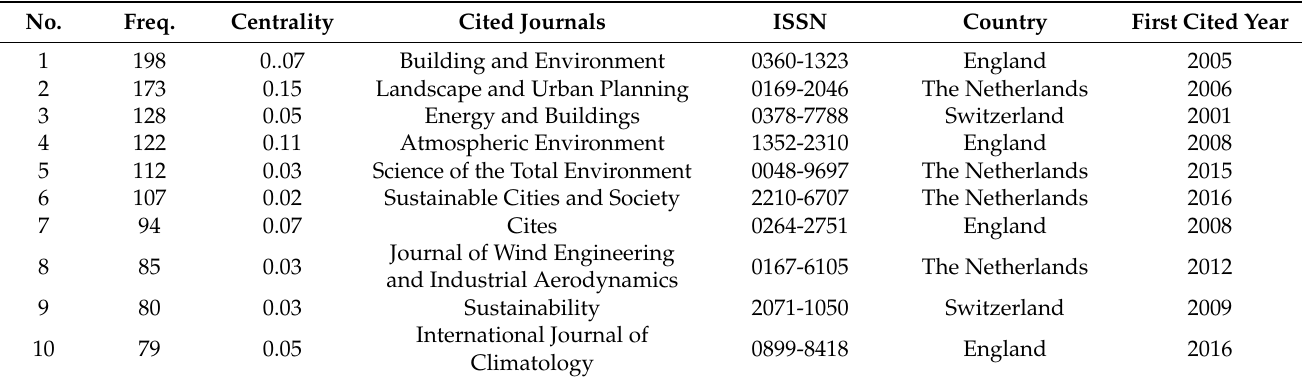
Figure 3. Knowledge map of co-journals of papers published in high-density cities from 2001 to 2022. Table 2. Major cited journals in the field of high-density cities from 2001 to